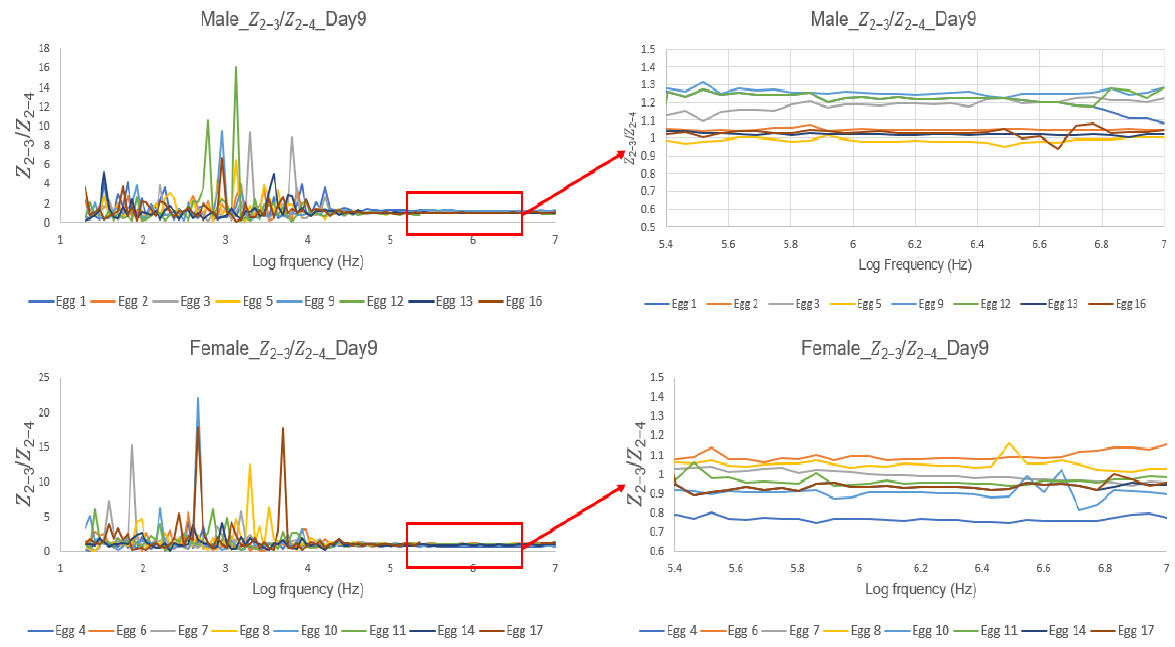
Figure 7. The self-normalized spectrum of impedance value of pair 2–3 divided by impedance value of pair 2–4.